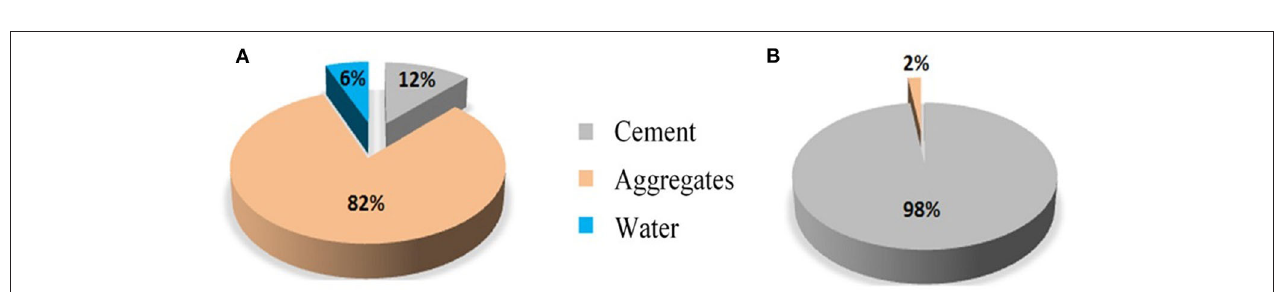
FIGURE 3 | Mass distribution of standard concrete (A) and associated CO 2 emissions (B)